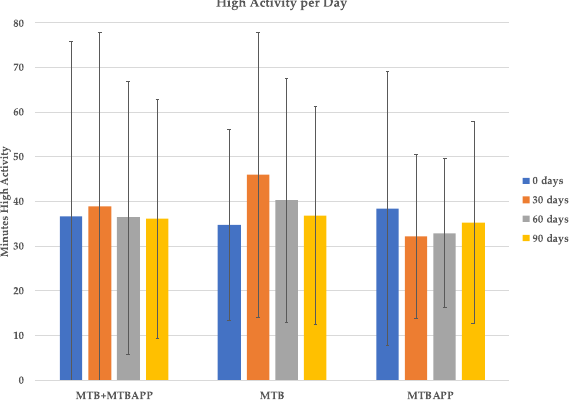
Figure 6. Physical activity data. * p < 0.05 by intragroup analysis.